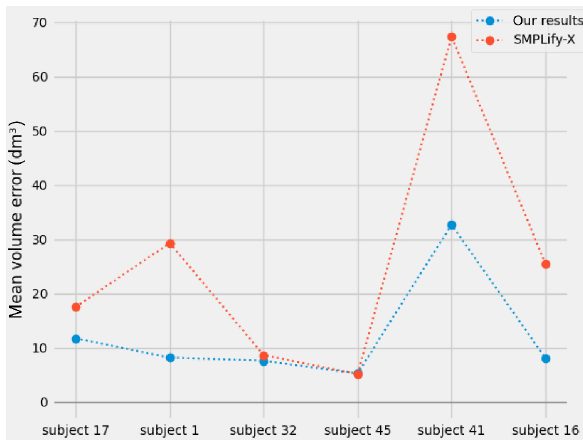
Fig. 7 Mean volume error for Simple Motion, subjects from MoVi.